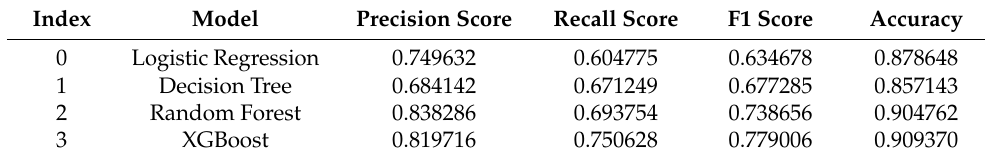
Table 1. Evaluation metrics for unbalanced data.